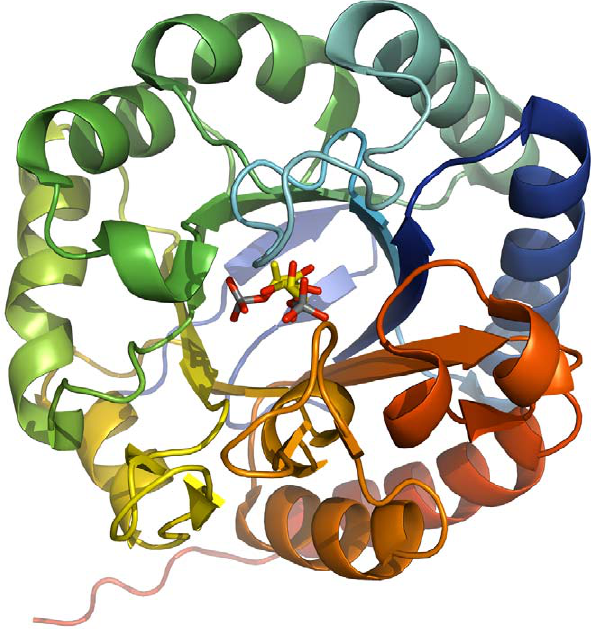
Figure 2. KDOP synthase from B.pseudomallei . KDOP synthase (2- dehydro-3-deoxyphosphooctonate aldolase, BURPS1710b_3264, PDB: 3UND with bound D-arabinose-5-phosphate), a KDO2-lipid A biosyn- thesis enzyme with a TIM barrel structure, was one of five structures solved for orthologs of the putative essential B. thailandensis gene, Bth_I1893.